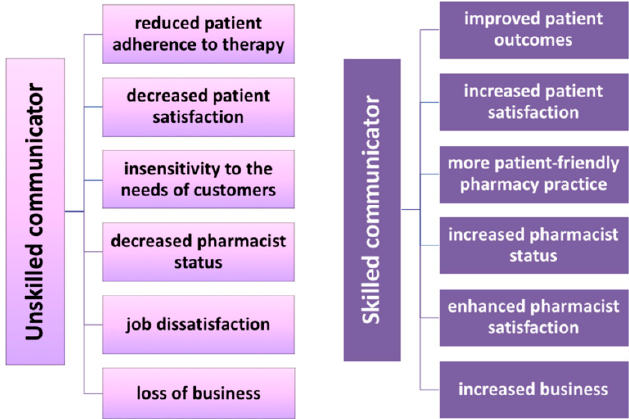
Figure 2. Consequences of the pharmacist as an unskilled or skilled communicator.